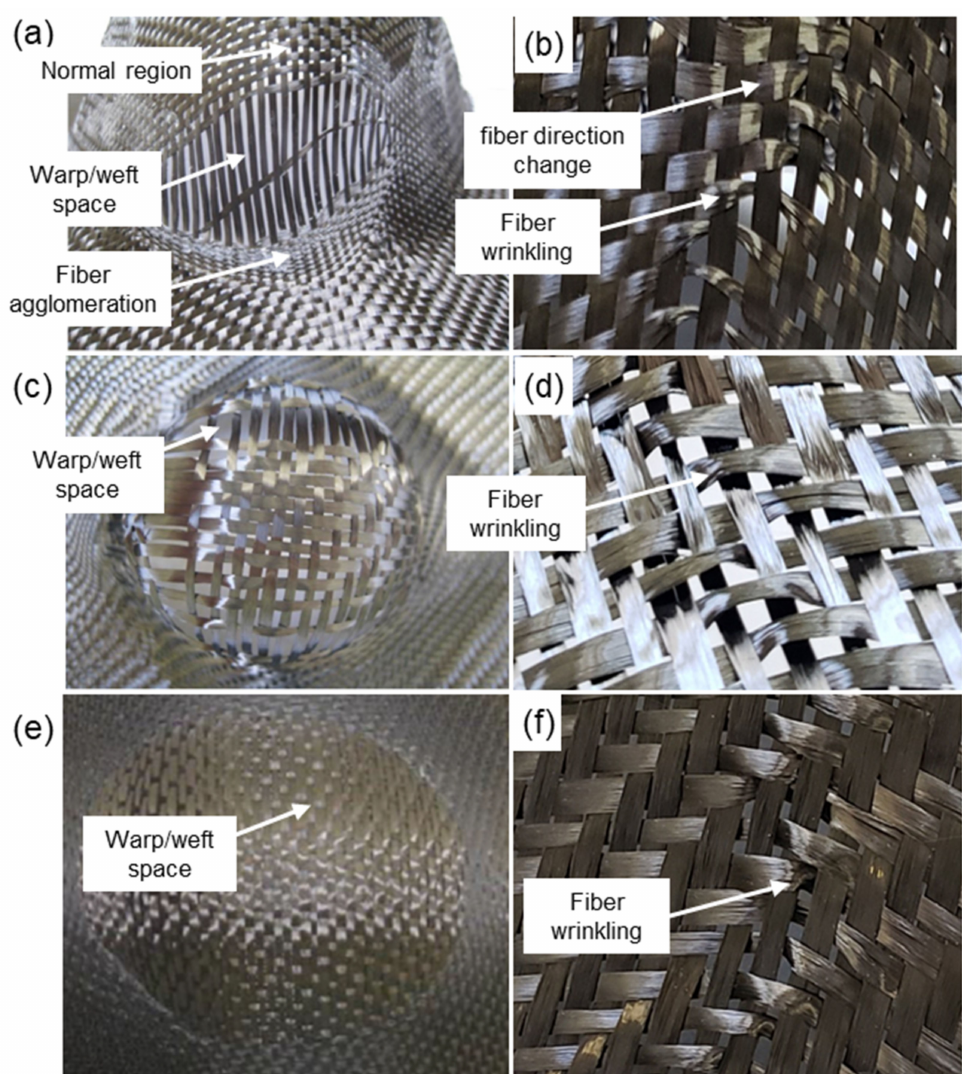
Figure 6. Optical microscopic images of fabric deformation: ( a , b ) plain weave 1 × 1; ( c , d ) twill weave; and ( e , f )